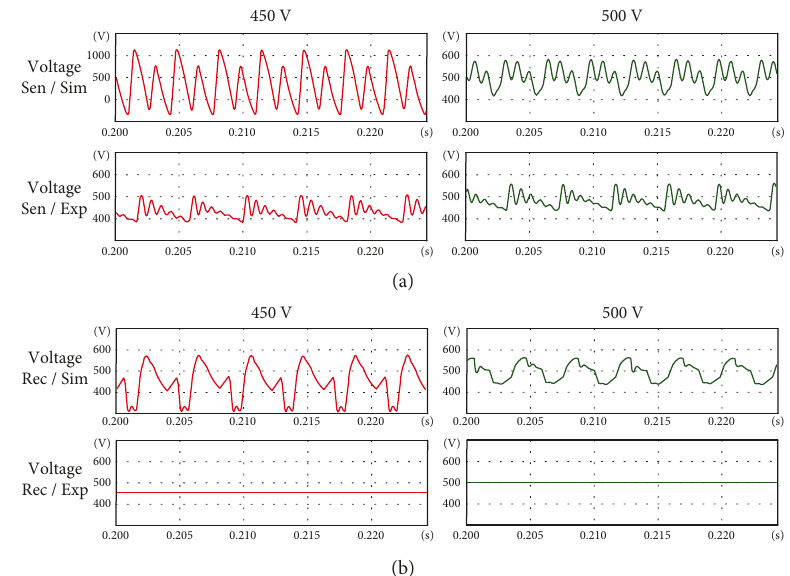
Figure 18: Comparison of the voltage waveforms based on the voltage conditions. (a) Comparison of the sending side current waveforms and (b) comparison of the receiving side voltage